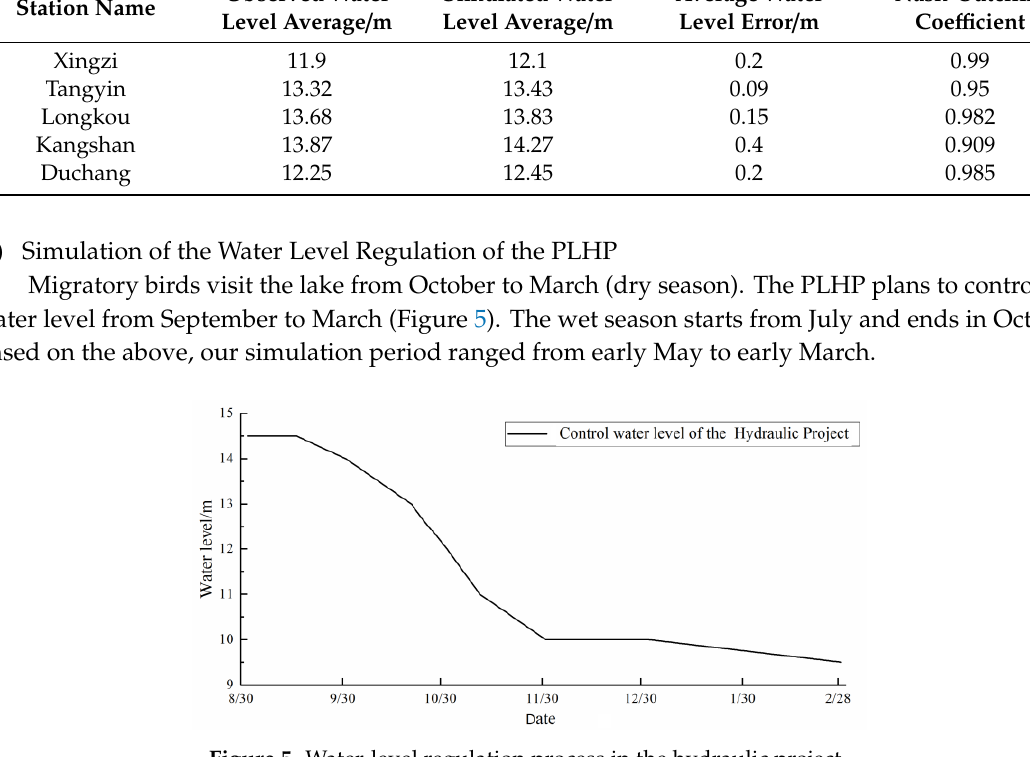
Figure 4. Verification of the hydrodynamic model. The yellow dots and line represent water discharge, and the rest represent the water level; the dotted line is the observation and the solid line is the simulation. Table 2. Analysis of model error. The average water level error is the difference between the simulated average water level and the observed average water level.